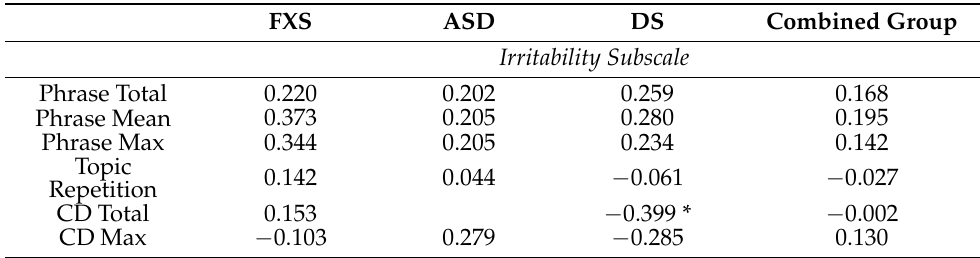
Table 8. Correlations between repetition measures and Irritability subscale while controlling for number of